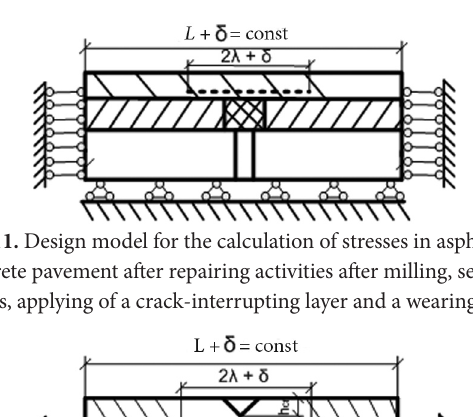
Fig. 10. Design model for the calculation of stresses in asphalt concrete pavement after repairing activities after milling, sealing cracks and applying of a wearing layer